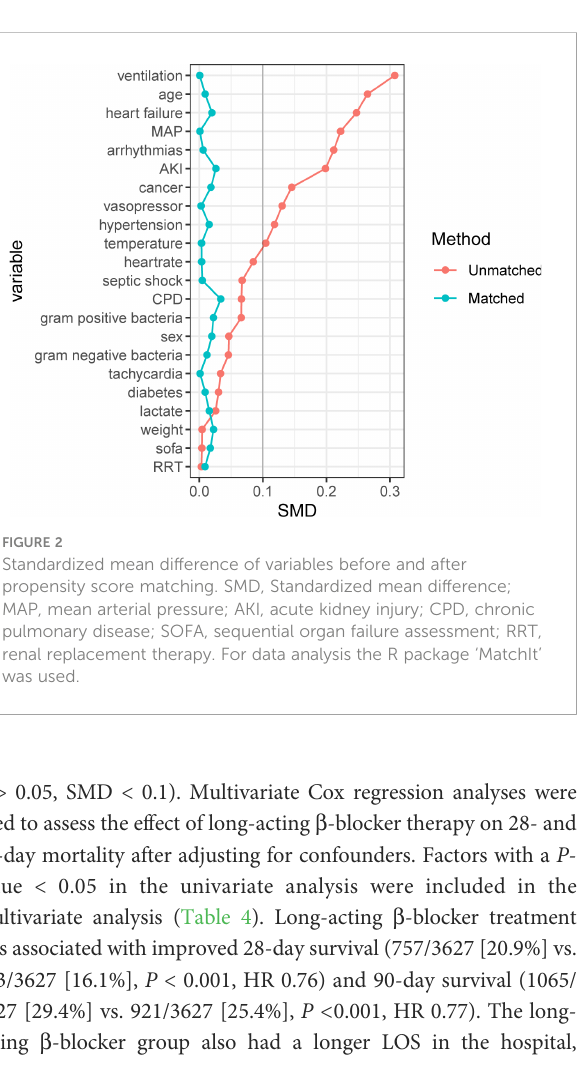
TABLE 2 Association between b -Blockers Therapy and clinical outcomes in sepsis.